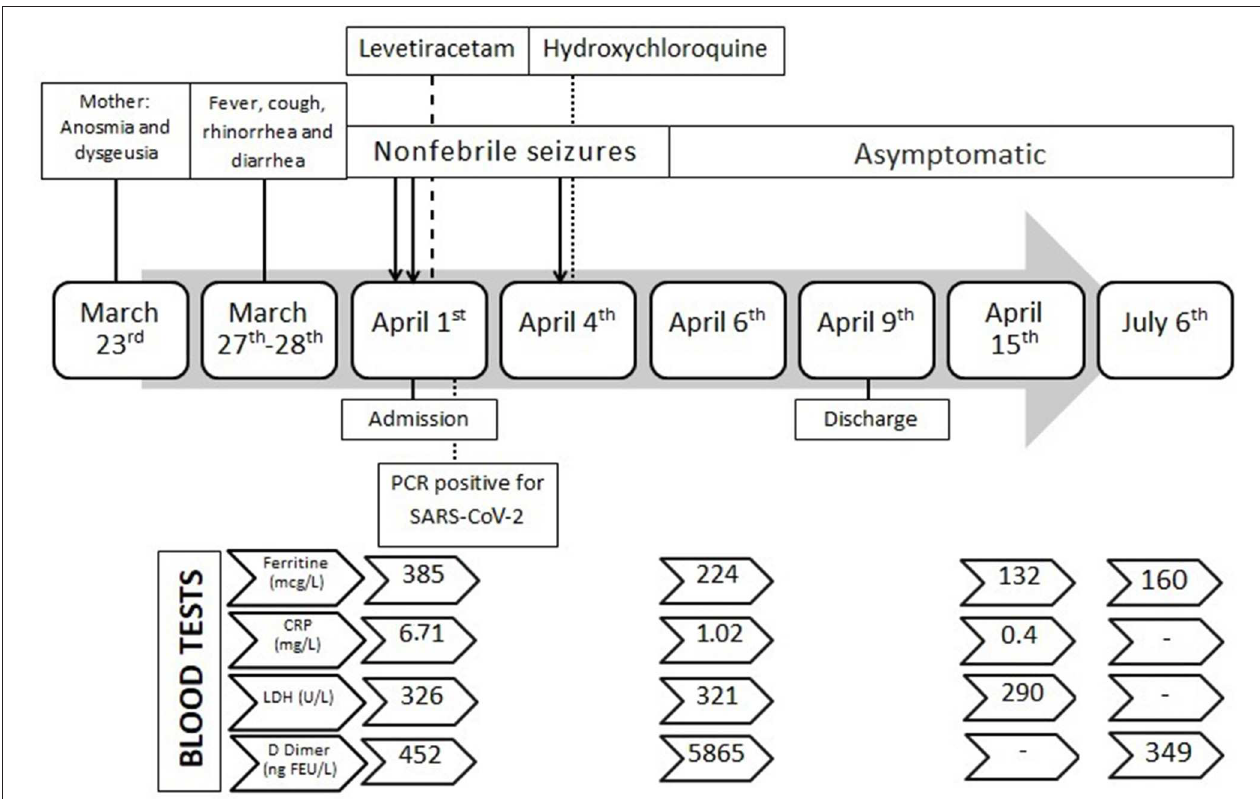
FIGURE 1 | Timeline course of the patient’s COVID-19